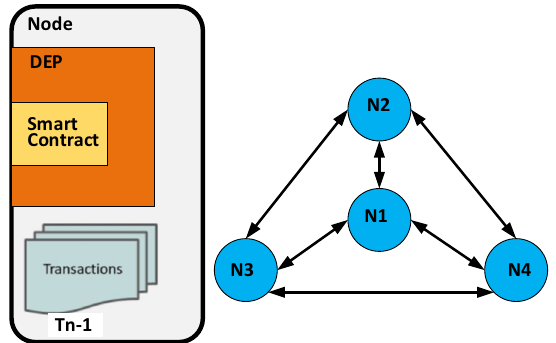
Fig. 4 General architecture model for a smart grid